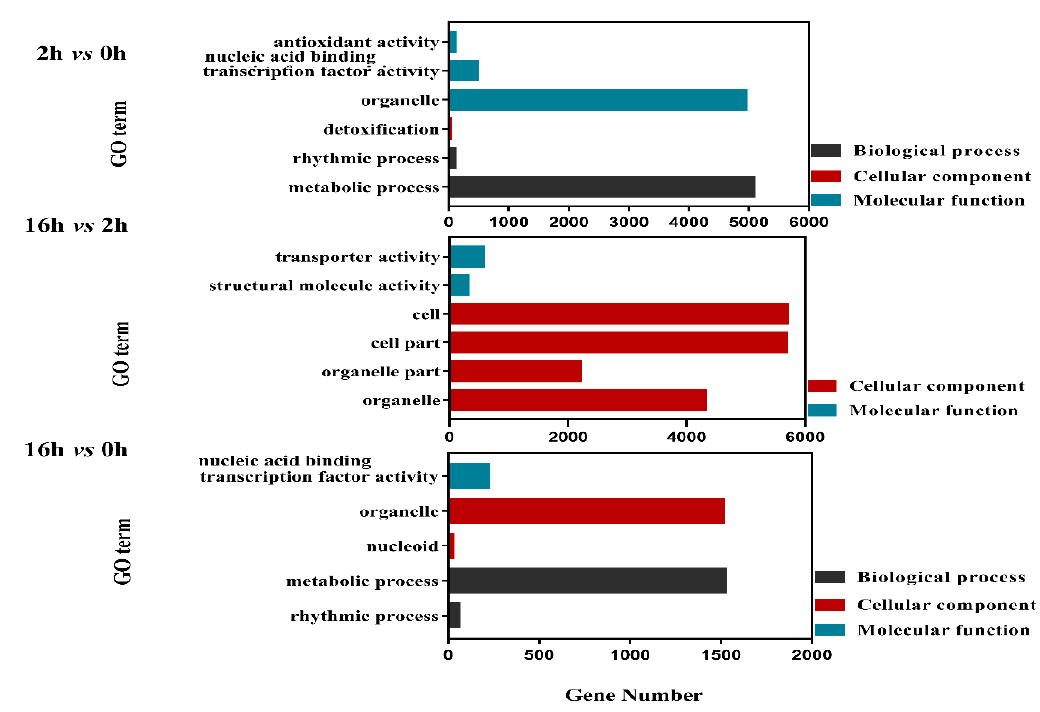
Figure 5. Bar plots of GO enrichment of DEGs with decreased expressions ( q Value < Figure 6. Bar plots of GO enrichment of DEGs with decreased expressions ( q Value < 0.05).